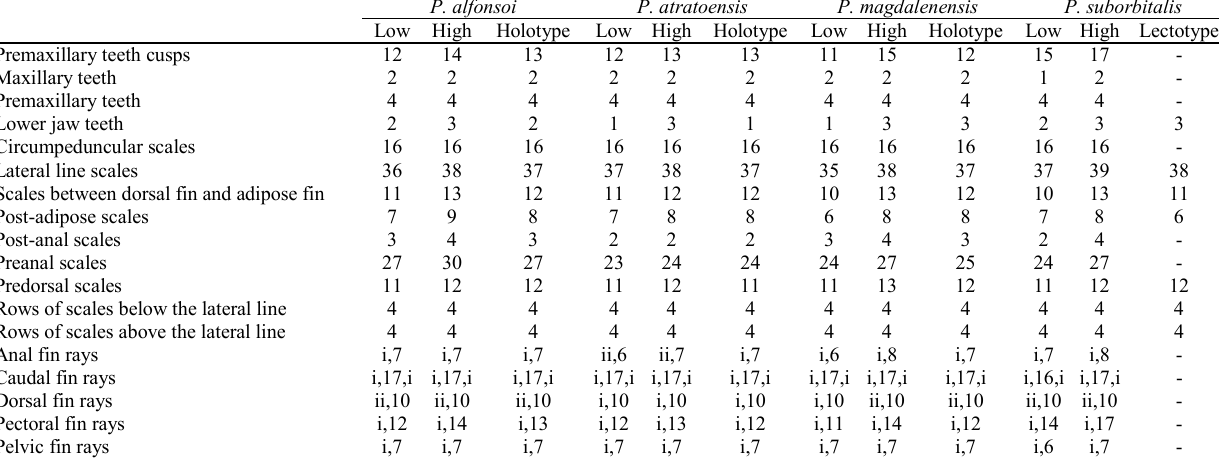
Table 2. Counts for Parodon alfonsoi (n = 14), P. atratoensis (n = 5) , P. magdalenensis (n = 70), and P . suborbitalis (n =